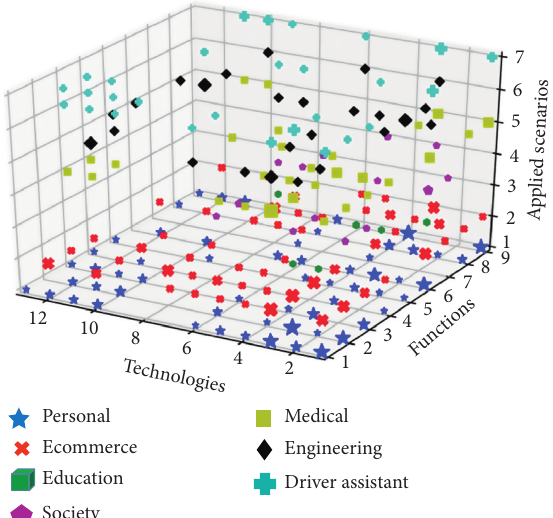
Figure 6: The three-dimensional